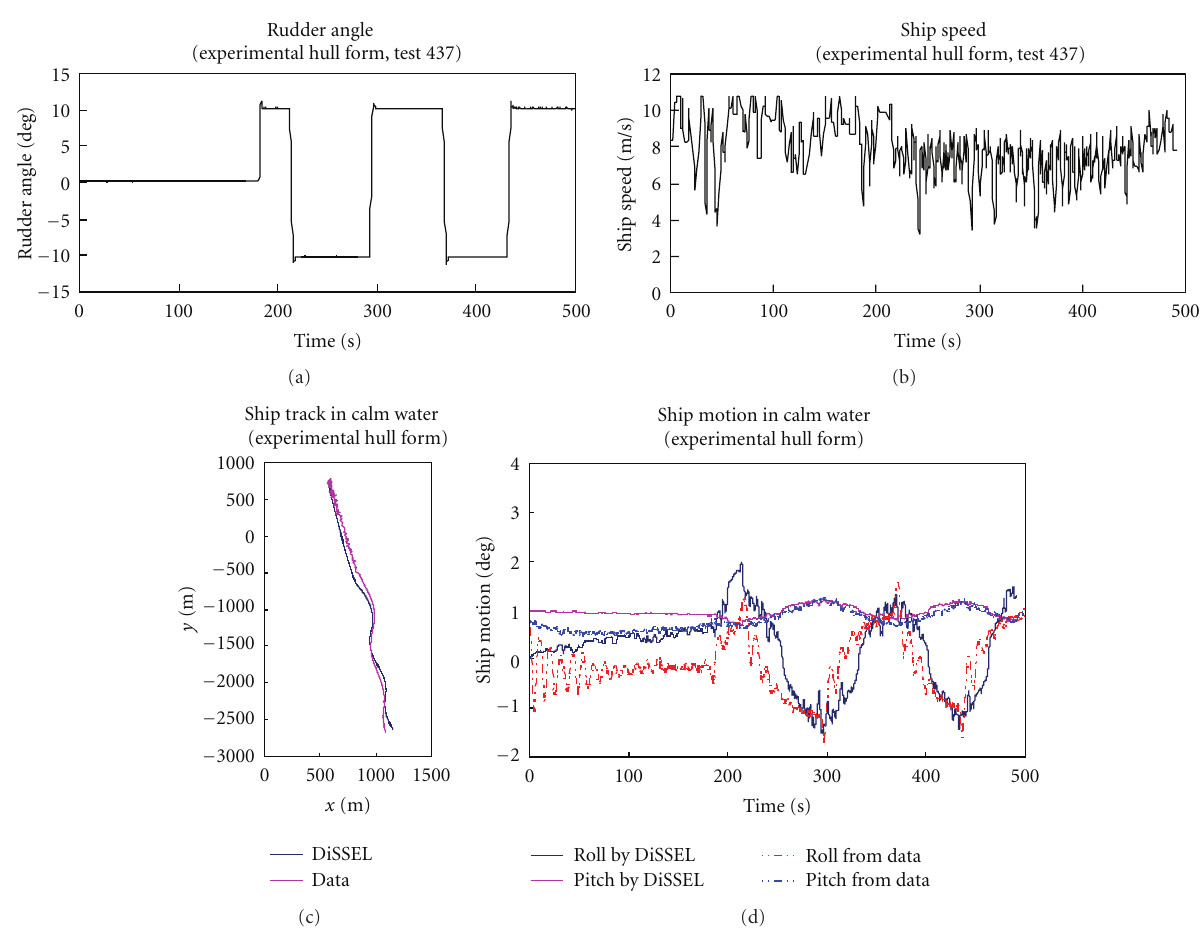
Figure 7: The data input for case 7 are shown in (a) and (b). (a) Rudder angle from data in test 437, (b) ship speed from data in test 437 Benchmark simulations for case 7 are shown in (c) and (d). (c) Comparison of roll and pitch motion between the simulation and experimental data in test 437. (d) Comparison of roll and pitch motions between simulation and experimental data in test